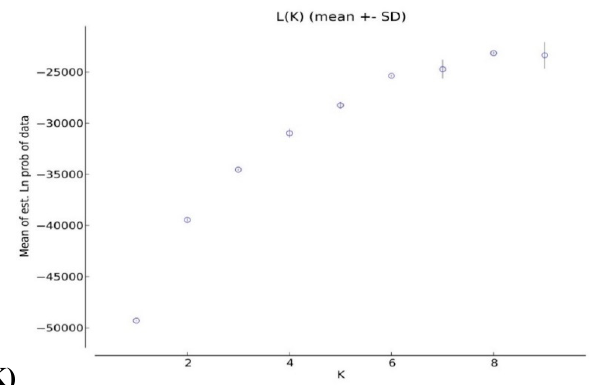
Figure 1. K means for 132 accessions.